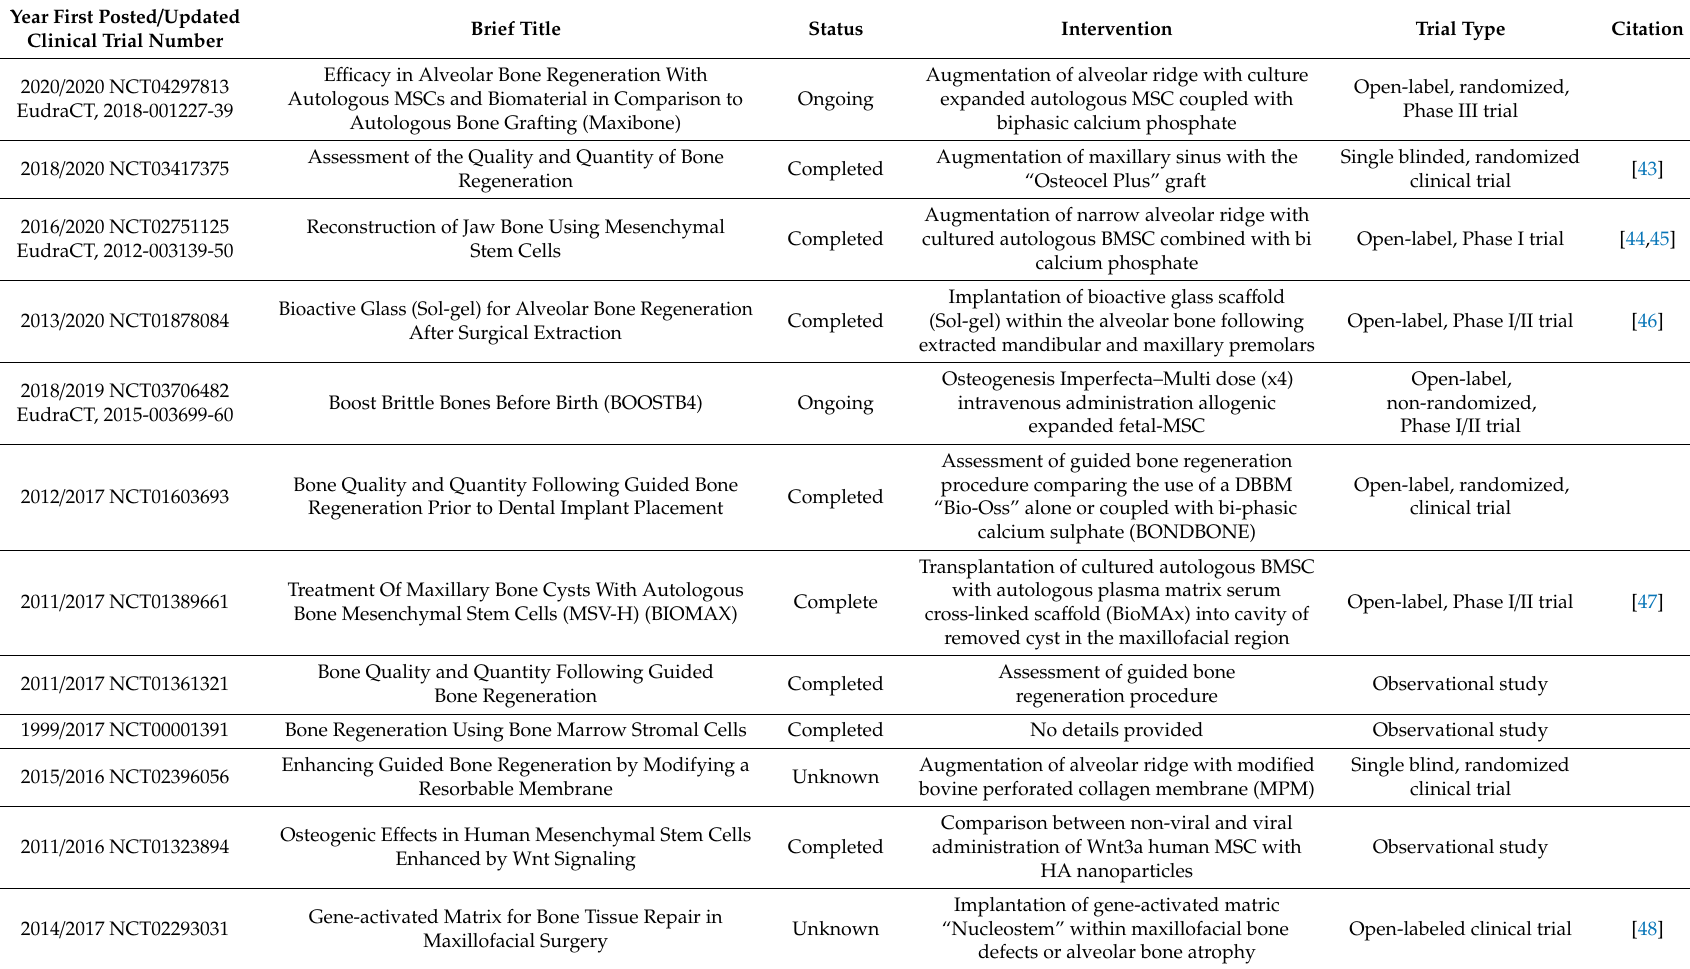
Table 2. Clinical Trials in Bone Regeneration. Search criteria in ClinicalTrails.gov: BMSC and bone regeneration, sca ff old and bone regeneration, stem cells and sca ff old and bone regeneration. Terminated trials, fracture related trials and cartilage related trials removed from the